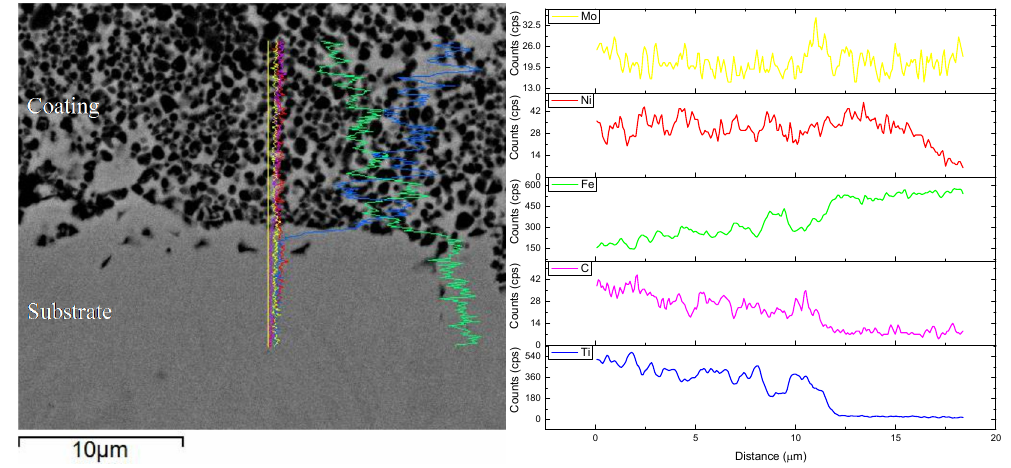
Figure 6. Line scanning spectra of the interface between the substrate and interlayer. Table 4. Cross ‐ sectional microhardness of the original coating.